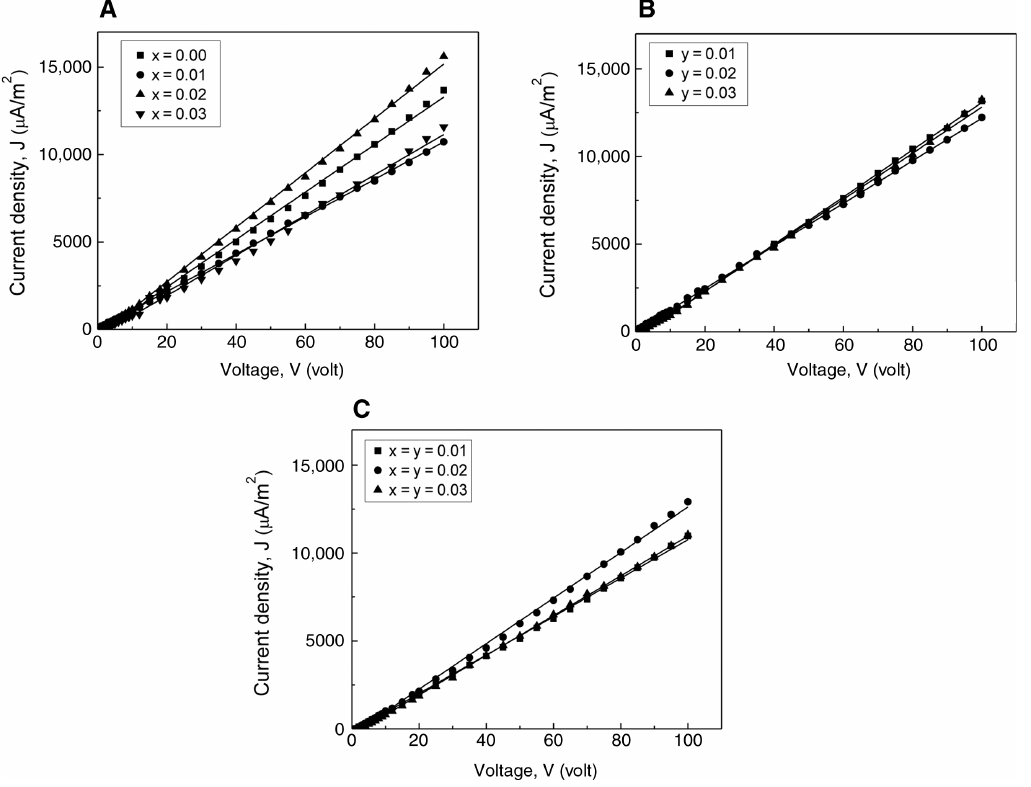
Figure 5: DC electrical properties of the (A) Ba 1 − x Ce x TiO 3 (x = 0.0, 0.01, 0.02, 0.03), (B) BaTi 1 − y Mn y O 3 (y = 0.01, 0.02, 0.03),